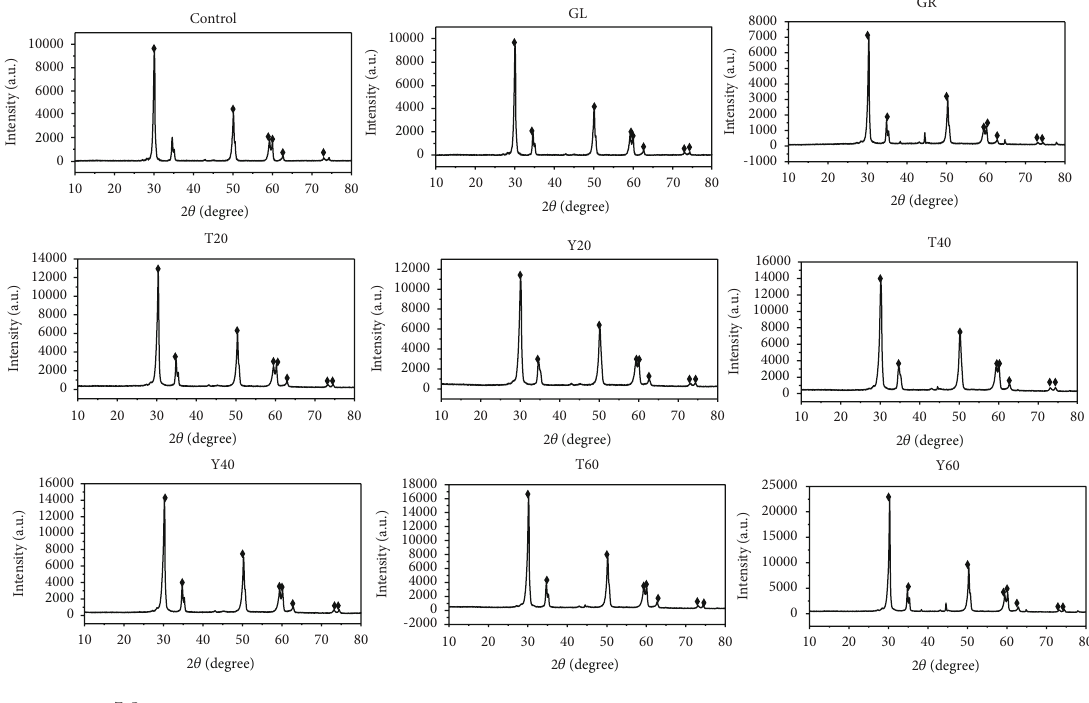
Figure 3: The detection of X-ray di ff ractometer (XRD) for crystal structure of specimens prepared with di ff erent polishing systems and di ff erent